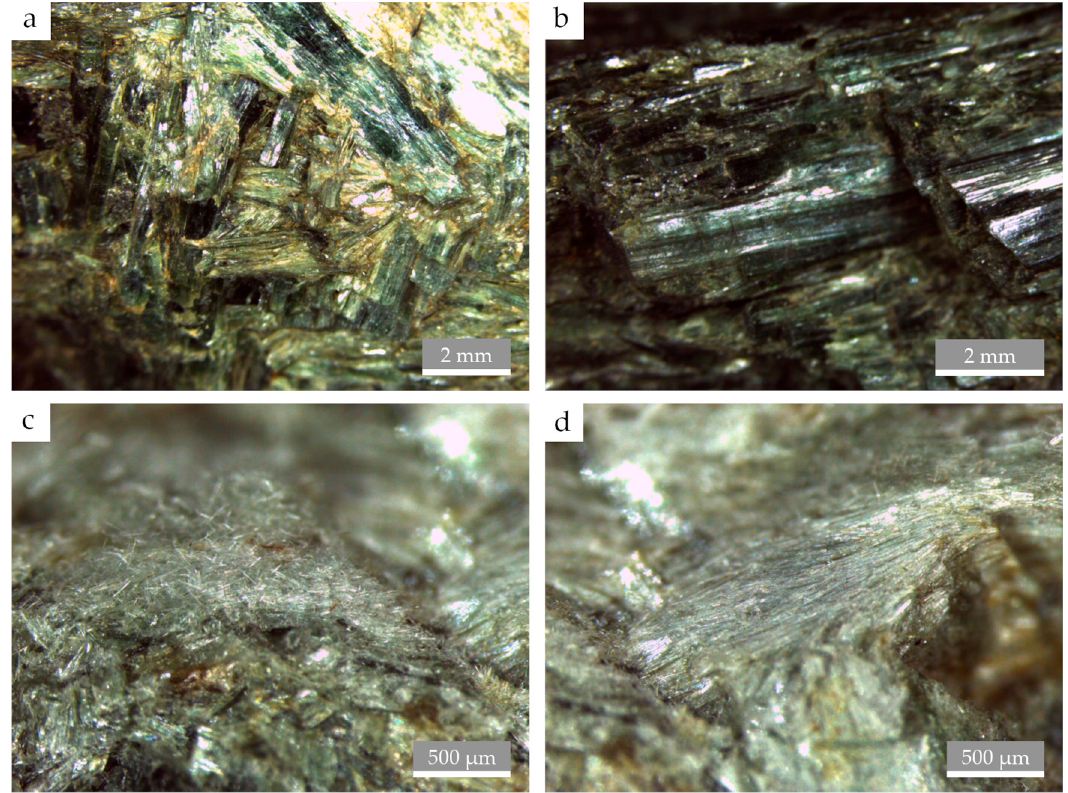
Figure 2. Visible-light microscopic images of the studied sample from Passo di Caldenno (Sondrio, Italy): ( a ) columnar and bladed crystals; ( b ) bigger columnar crystals; ( c ) randomly oriented fibers; ( d ) parallel fibers.